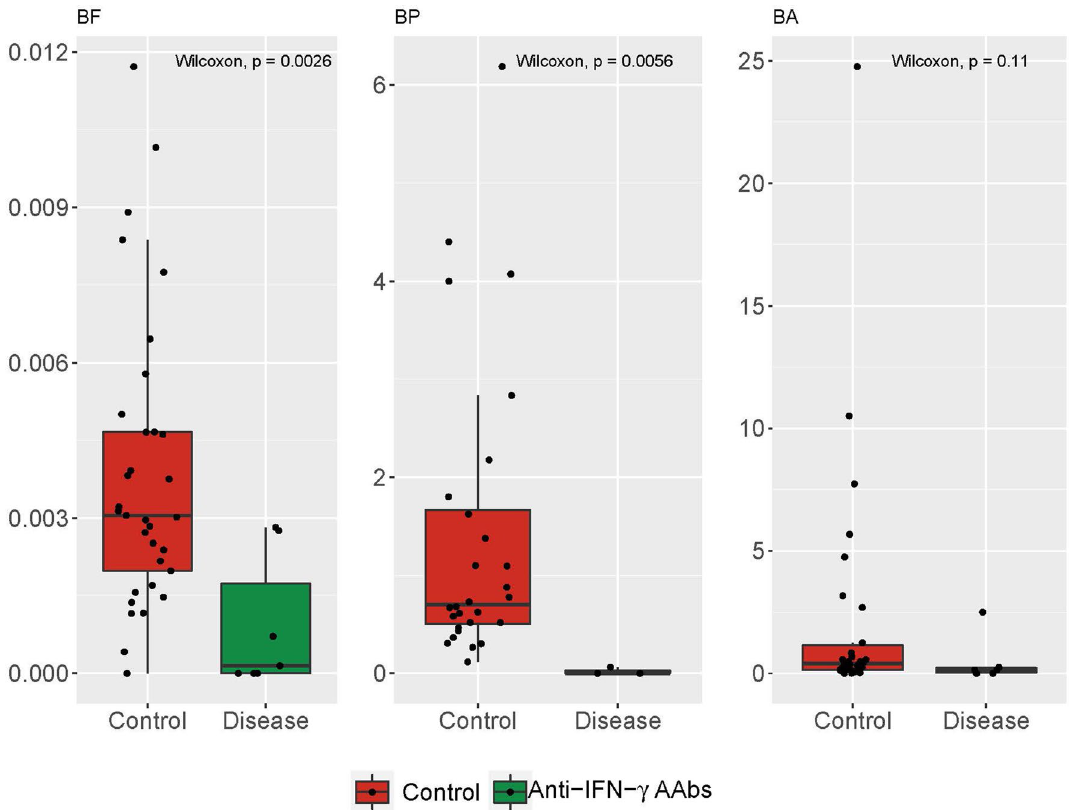
Figure 4. The relative abundances of the 4 major phyla of the fecal samples between Anti-IFN-γ AAbs and HC cohorts. Different combinations of Bacteroidetes/phyla between HC and Anti-IFN-γ AAbs groups. anti-IFN-γ AAbs anti-interferon-gamma autoantibodies, HC healthy